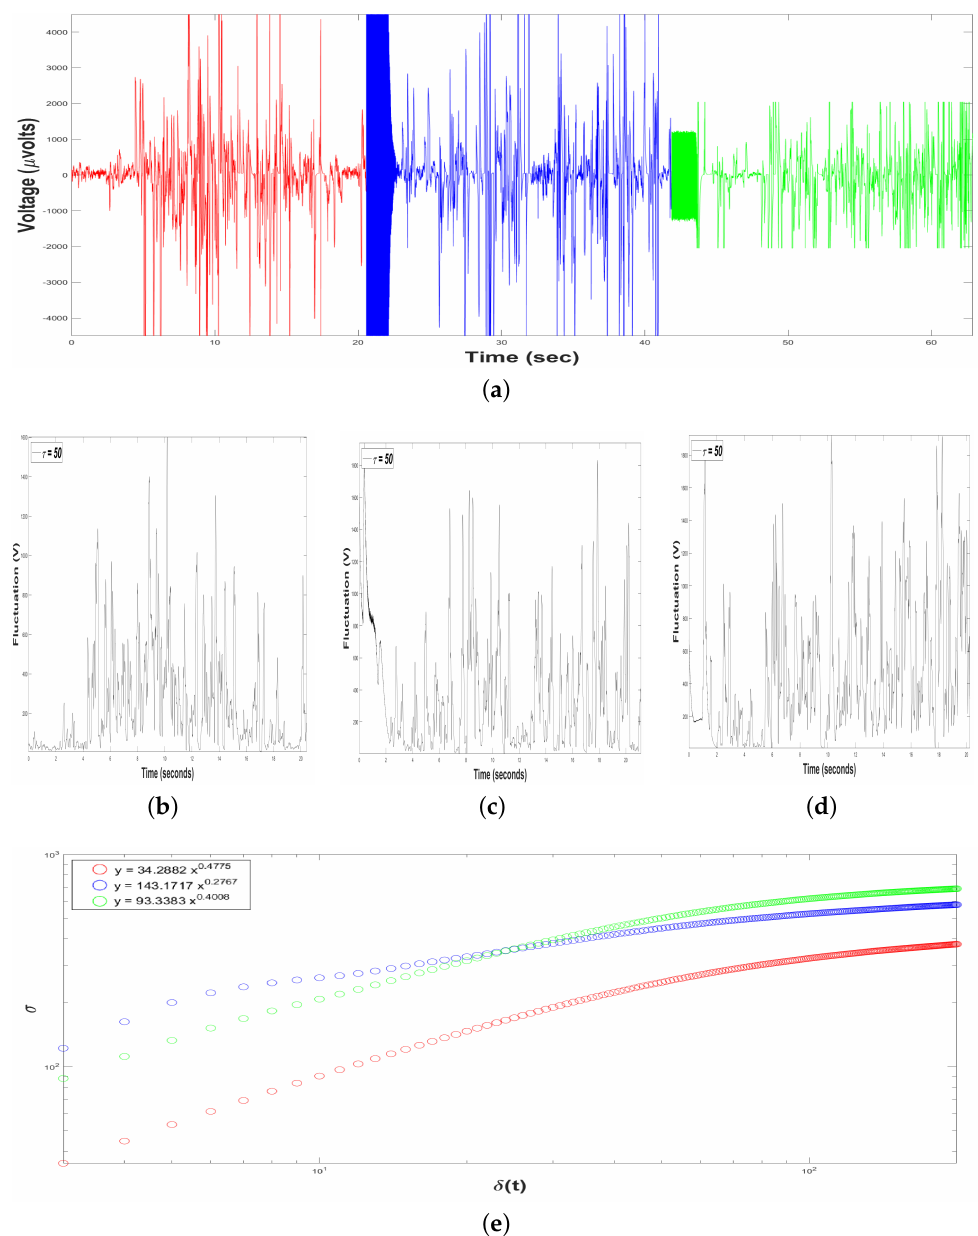
Figure 5. Results of Dolphin EEG brain activity from Experiment Design. ( a ) Representation of the RAW data x ( t ) ( µ V vs. sec) for the first measure (in red color), the second measure (in blue color) and the third measure (the green color). ( b – d ) Time series of fluctuation of Dolphin EEG brain activity, F ( t + τ ) for τ = 50: for the first measure ( b ), the second measure ( c ) and the third measure ( d ). ( e ) Structure function of fluctuations of Dolphin EEG brain activity, ( σ ( τ , δ t ) vs. δ t ) for 3 ≤ τ ≤ 200, for the first measure (in red color), the second measure (in blue color) and the third measure (in green